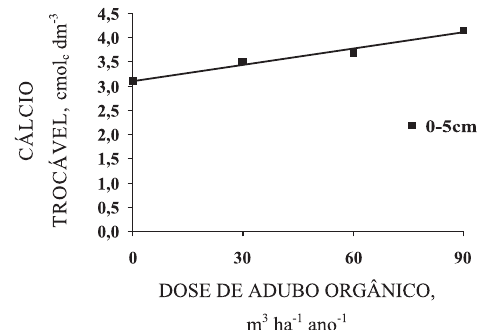
Figura 3. Teor de cálcio trocável em em Latossolo Bruno sob plantio direto submetido a diferentes doses de esterco líquido de gado leiteiro, por um período de seis anos, com remoção total da planta.